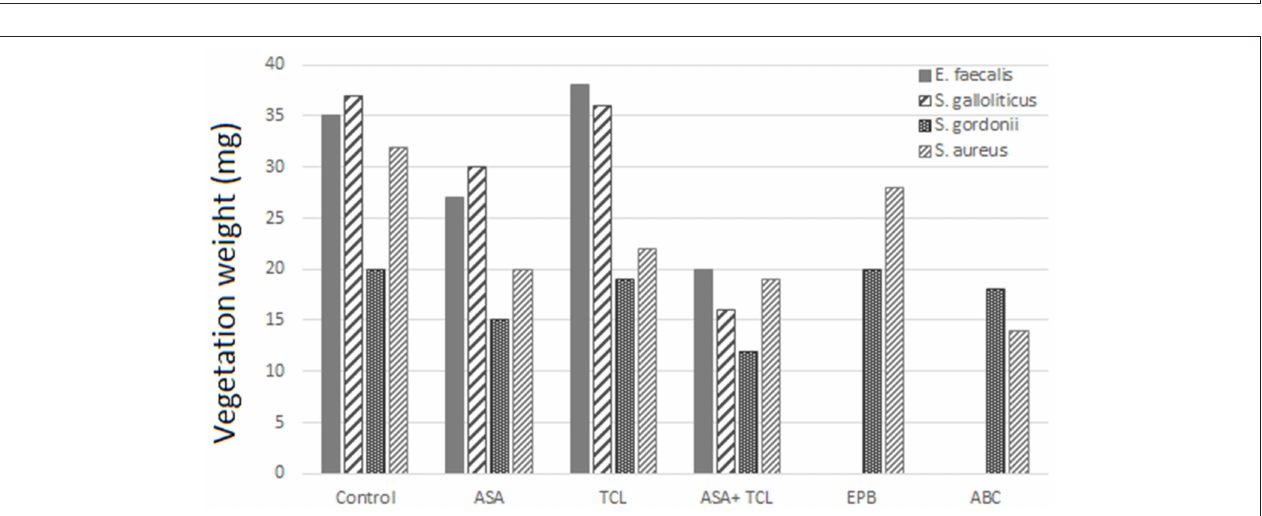
FIGURE 3 | Effect of antiplatelet agents on the rate of infected vegetations in the animal model. Effect of aspirin (ASA), ticlopidine (TCL), alone or in combination, as well as eptifibatide (EPB) and abiciximab (ABC) on the prevention of experimental infective endocarditis induced by E. faecalis , S. gallolyticus , S. gordonii , and S. aureus “yellow.” Eptifibatide and abciximab in the case of S. gordonii and S. aureus ( 84, 86).